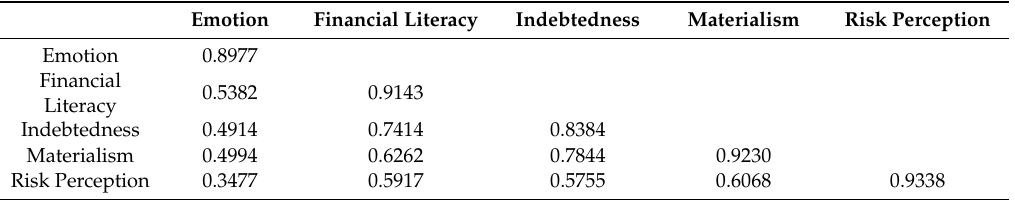
Table 3. Discriminant validity Fornell–Larcker